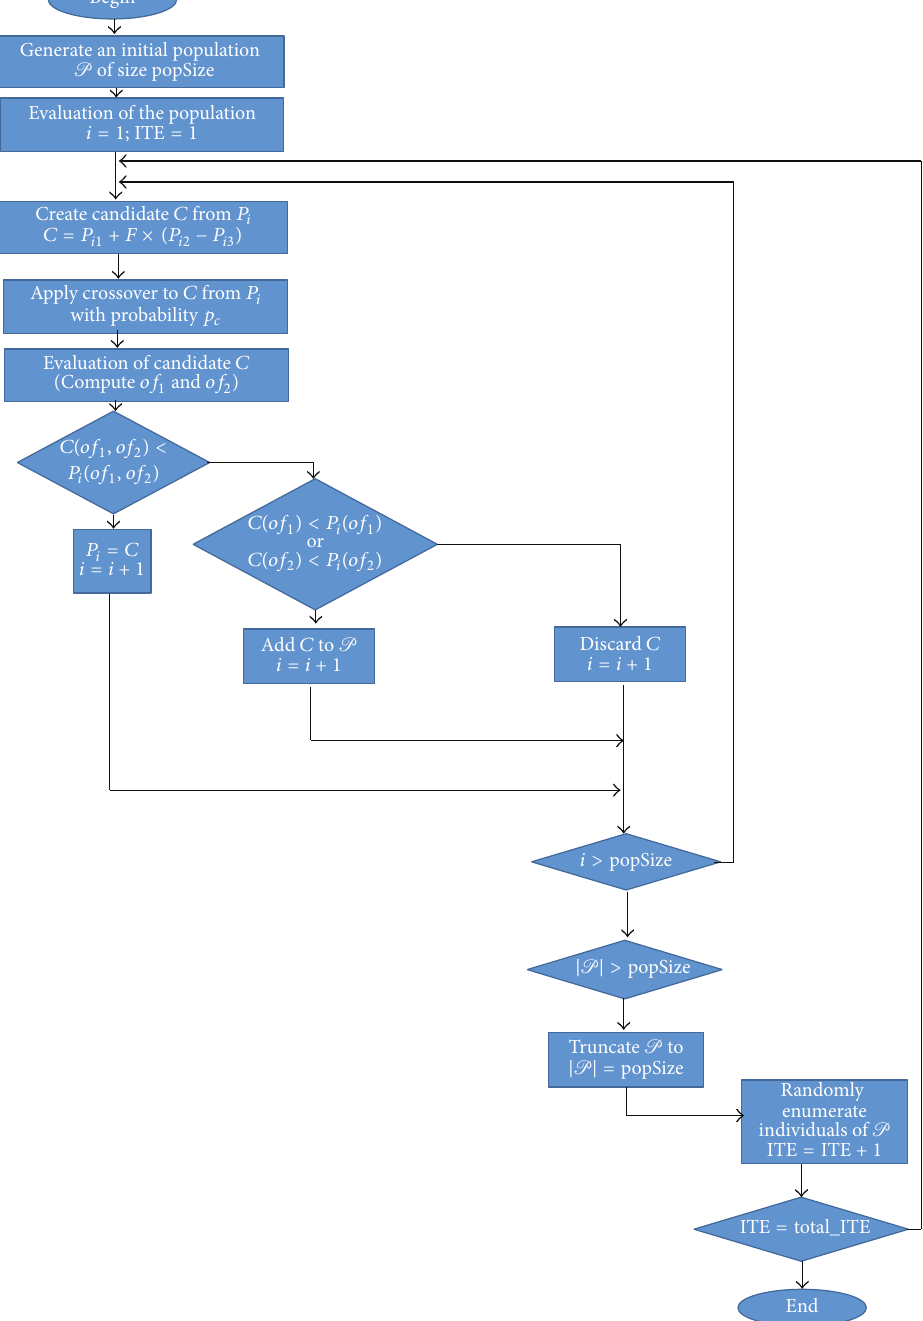
Figure 2: Flow chart for the implemented DEMO/parent